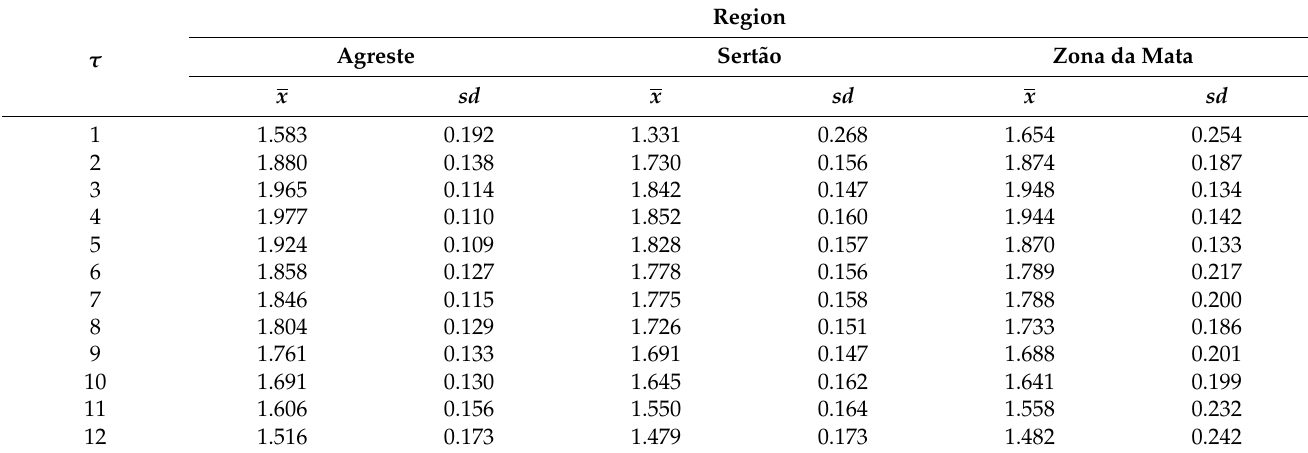
Table 2. Average MMSE values (together with standard deviation) for rainfall anomalies series.